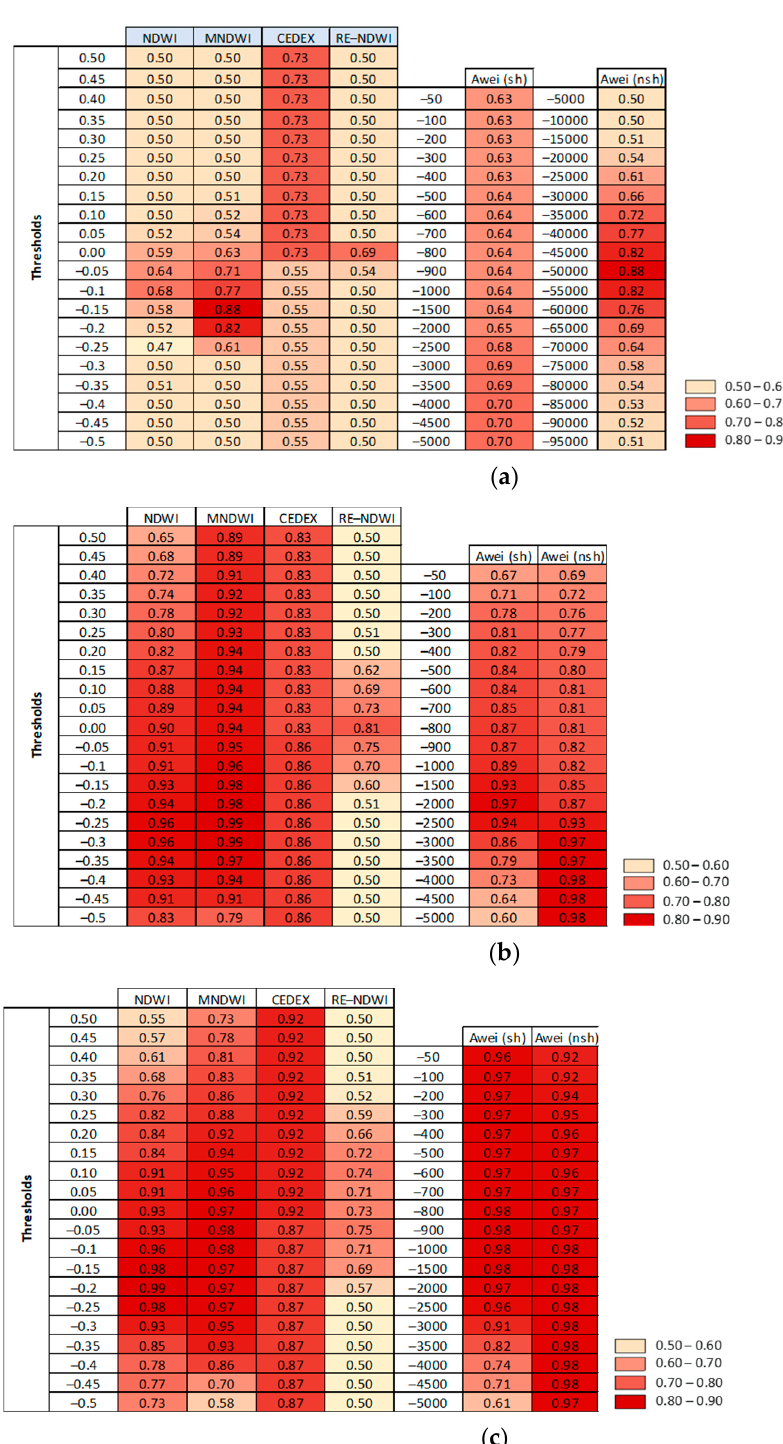
Figure 2. Overall accuracies for a set of thresholds applied to the Landsat-5 ( a ), Landsat-8 ( b ), and Sentinel-2 images ( c ). Light shaded colors show the indices and thresholds with poorest performance. Shaded in red colors are used for indices and thresholds with the most accurate (closer to 1).